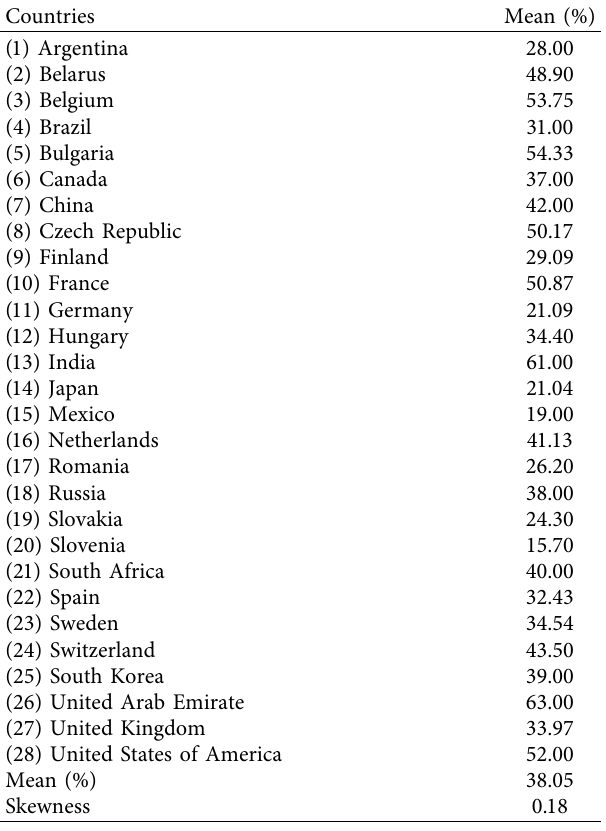
Table 3: Te mean values of public acceptance in various countries.